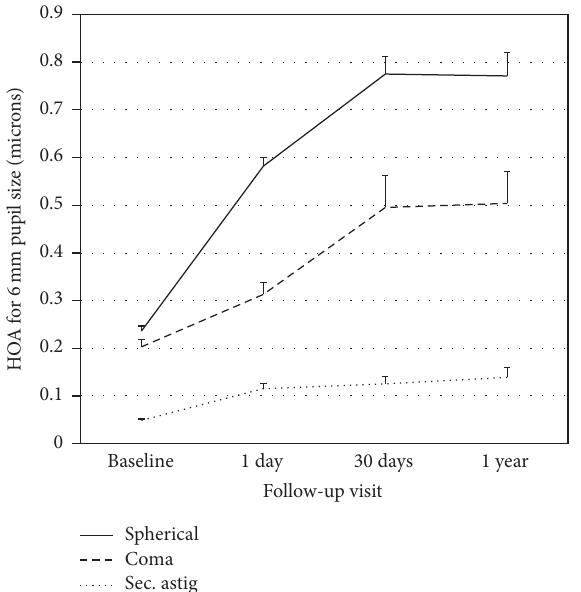
Figure 3: Monocular CSF. Error bars represent the standard error Figure 2: Optical quality of the corneal front surface for 6 mm of the mean (SEM). pupil size represented by the root mean square (RMS) of spherical- like aberrations, coma-like aberrations, and secondary astigmatism. Error bars represent the standard error of the mean (SEM). Table4:ChangesinCSbetweenbaselineandfollow-upvisits(mean difference ± SEM) for those frequencies showing significant changes between Table 3: Changes in HOA between baseline and follow-up visits (mean difference ± SEM) for RMS values showing statistically significant changes for 6mm pupil size. Δ ± SEM Sig.